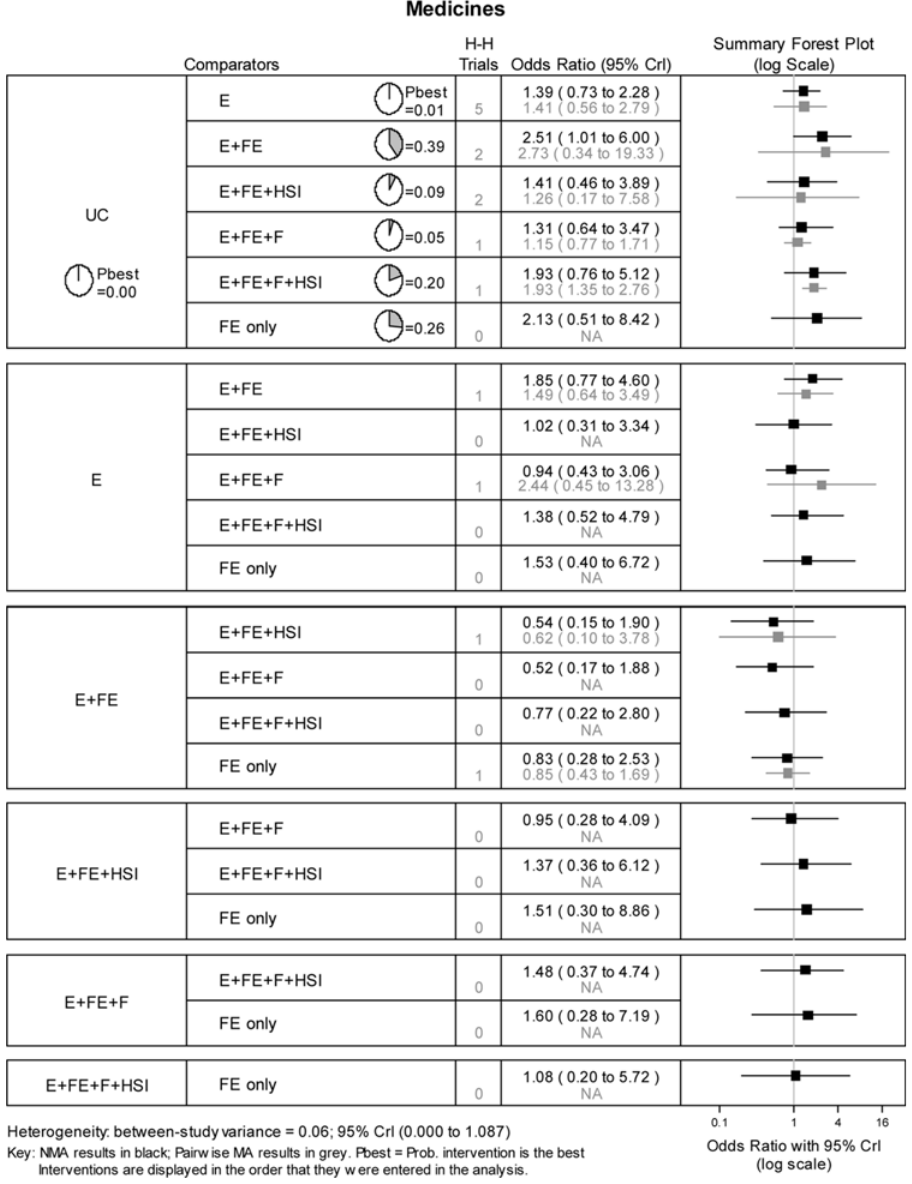
Fig 3. Network meta-analysis results for safe storage of medicines. H-H trials refer to the number of head-to-head trials available for the specified pairwise comparison.